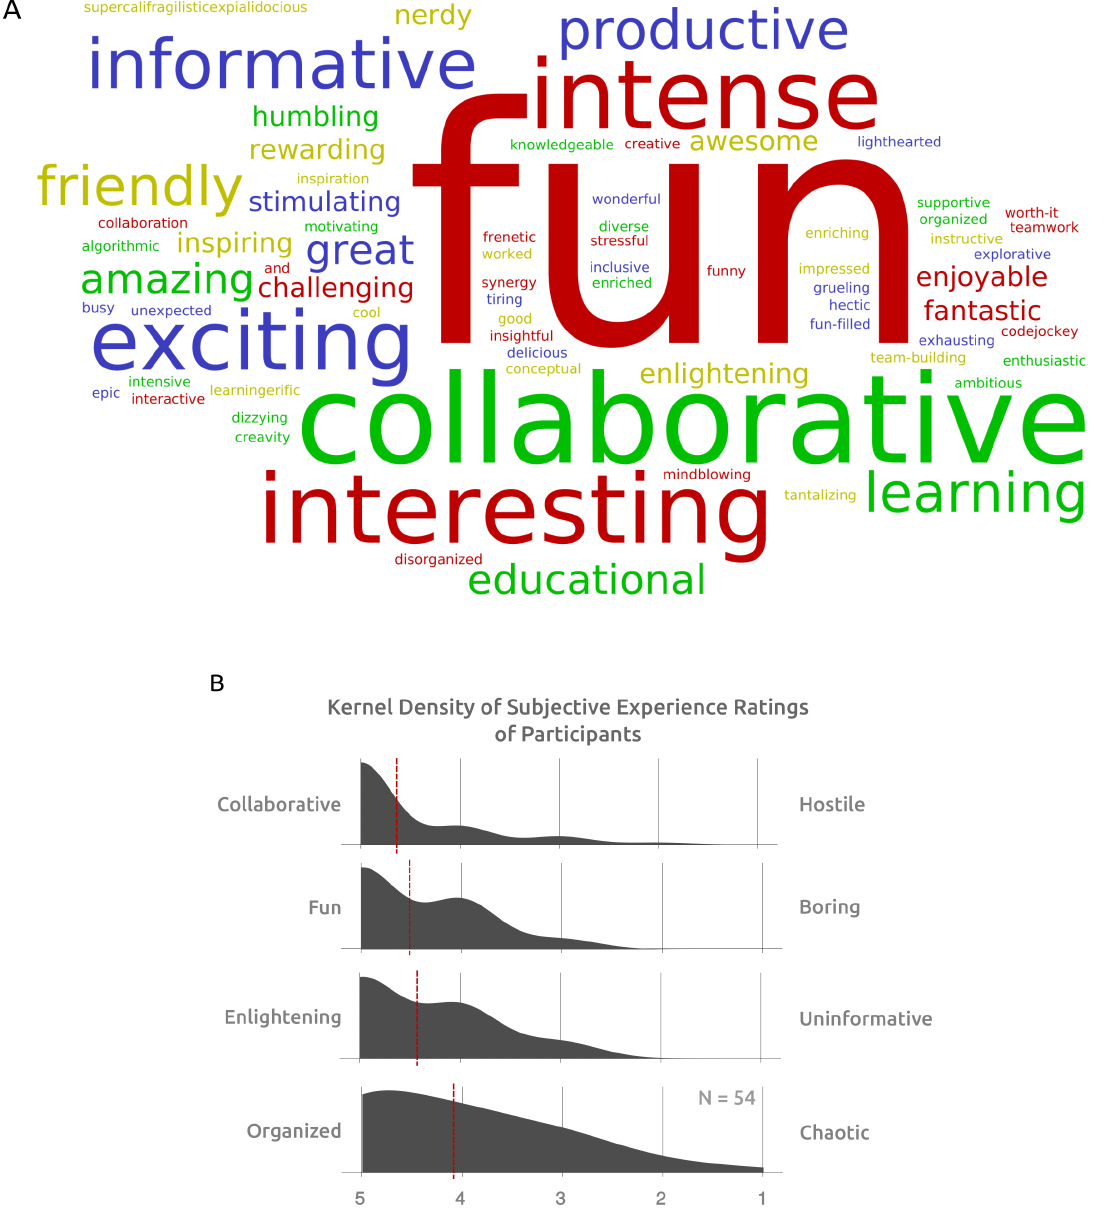
Figure 3. Quantification of subjective experience. To measure the quality of the experience hackseq participants had after the event, we asked ( A ) “Please write three single word adjectives to describe your experience at hackseq?” Responses were parsed and used to make a word-cloud (www.wordle.net), where the size of the word is proportional to the number of occurrences of that word in the survey responses. For scale, in 50 responses: ‘fun’ was mentioned 26 times; ‘exciting’ 6 times; and ‘supercalifragilisticexpialidocious’ once. ( B ) Additionally, we asked participants to rate four dimensions of their experience on a linear scale from 1 to 5. The kernel density of responses for these dimensions are shown, with a red dotted line showing the mean value of the responses.